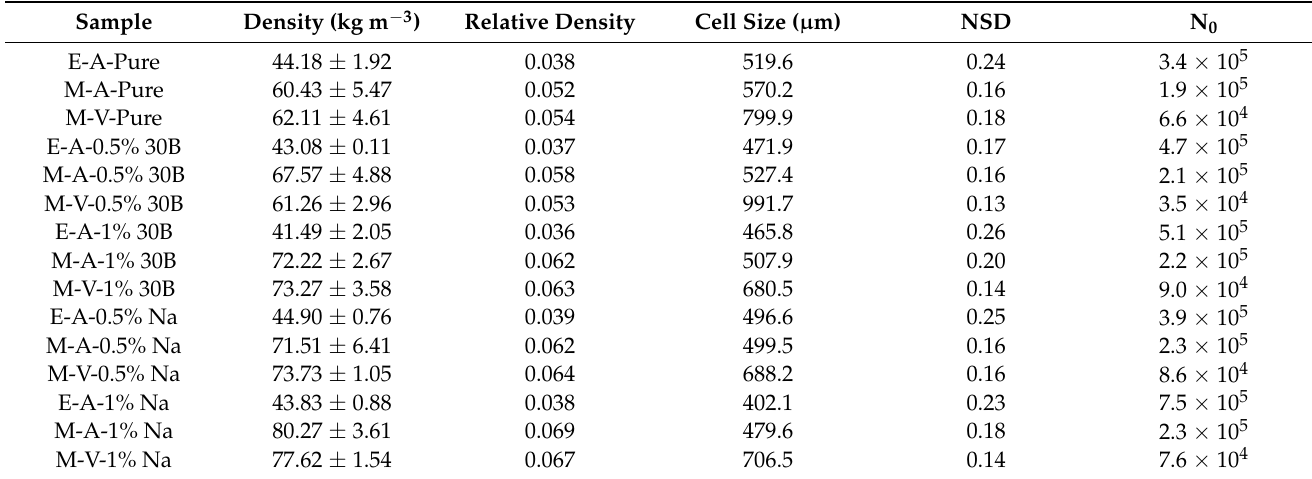
Table 5. Geometrical and relative densities for pure PU foams and Cloisite ® 30B or Cloisite ® Na + filled foams fabricated under atmospheric and vacuum conditions, cell size values, and cell nucleation